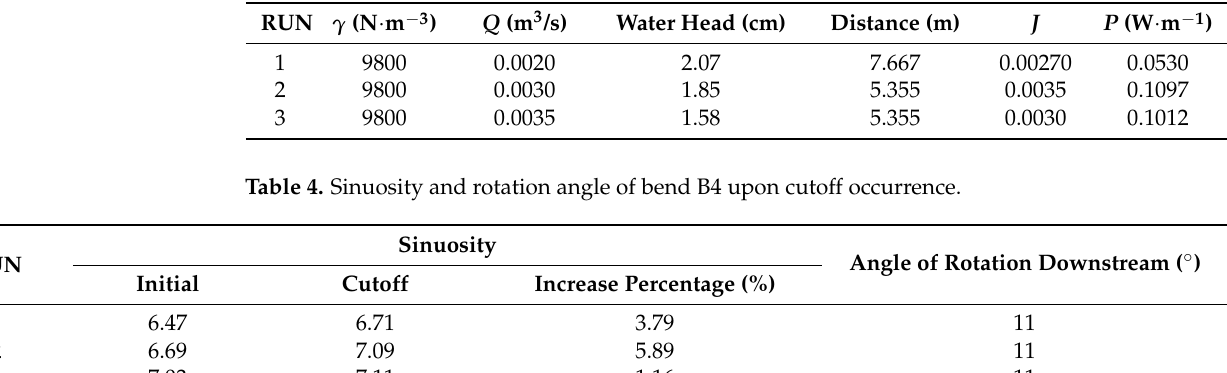
Table 3. Critical stream power per unit length at neck cutoff occurrence.